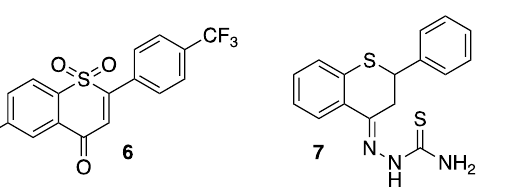
Figure 2. Thiochromanones with activity against Leishmania.